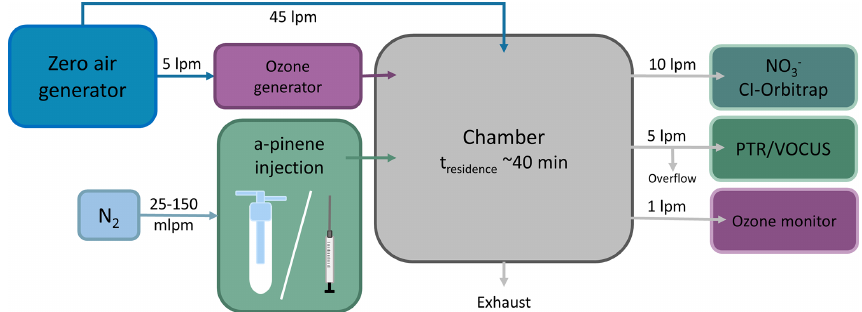
Figure 3. The experimental set-up consists of a continuous stirred-tank reactor (CSTR). Additionally, there are ozone and zero-air generators, an α -pinene injection set-up, an ozone monitor, a nitrate CI-Orbitrap, and a PTR or a